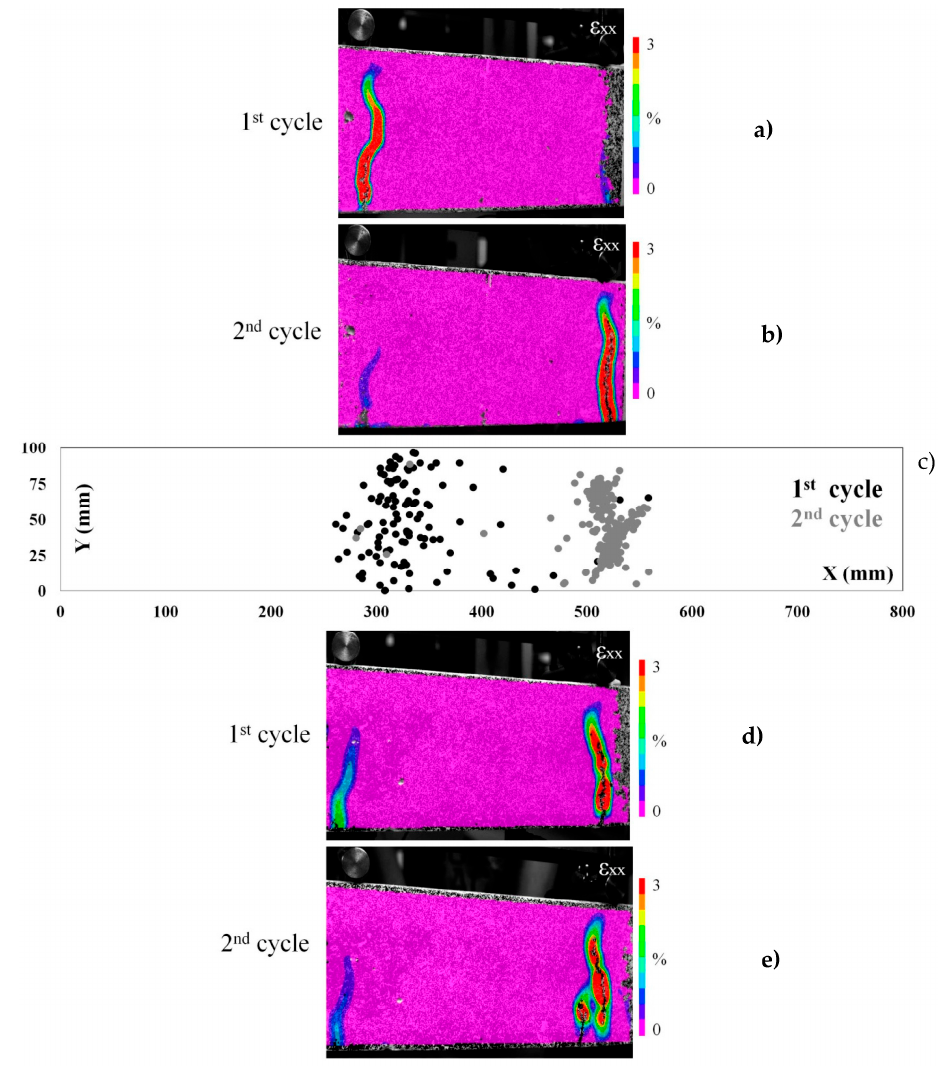
Figure 10. ( a , b ) The strain ( ε xx ) maps of beam carrying ceramic (alumina) network healing system at loading and reloading test cycles; ( c ) the AE events location map (X versus Y coordinates) is given for the first beam; and ( d , e ) the strain ( ε xx ) maps of a second beam with the same healing system.